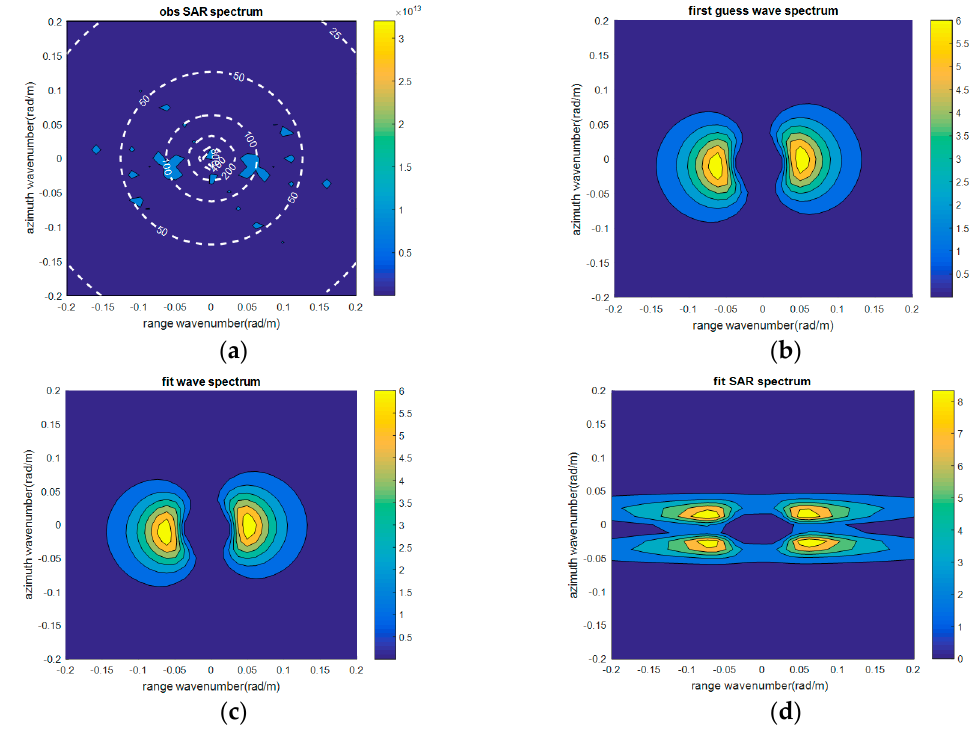
Figure 13. SAR-3: MPI algorithm inversion results as follows: ( a ) Observed SAR spectrum (after horizontal flip), ( b ) first guess PM wave spectrum, ( c ) fit PM wave spectrum, and ( d ) fit SAR spectrum.